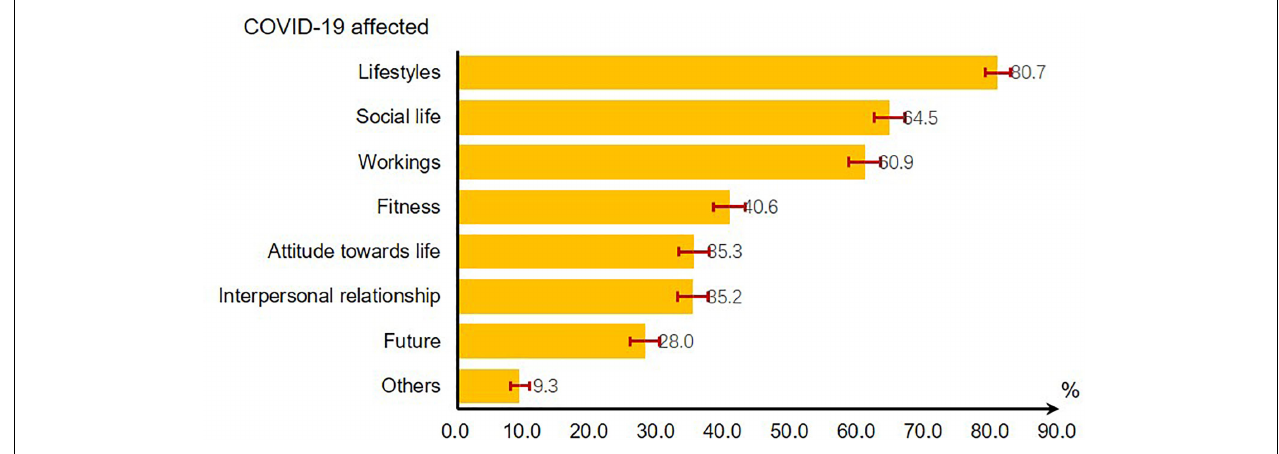
FIGURE 1 | The impact of COVID-19 on people’s life in